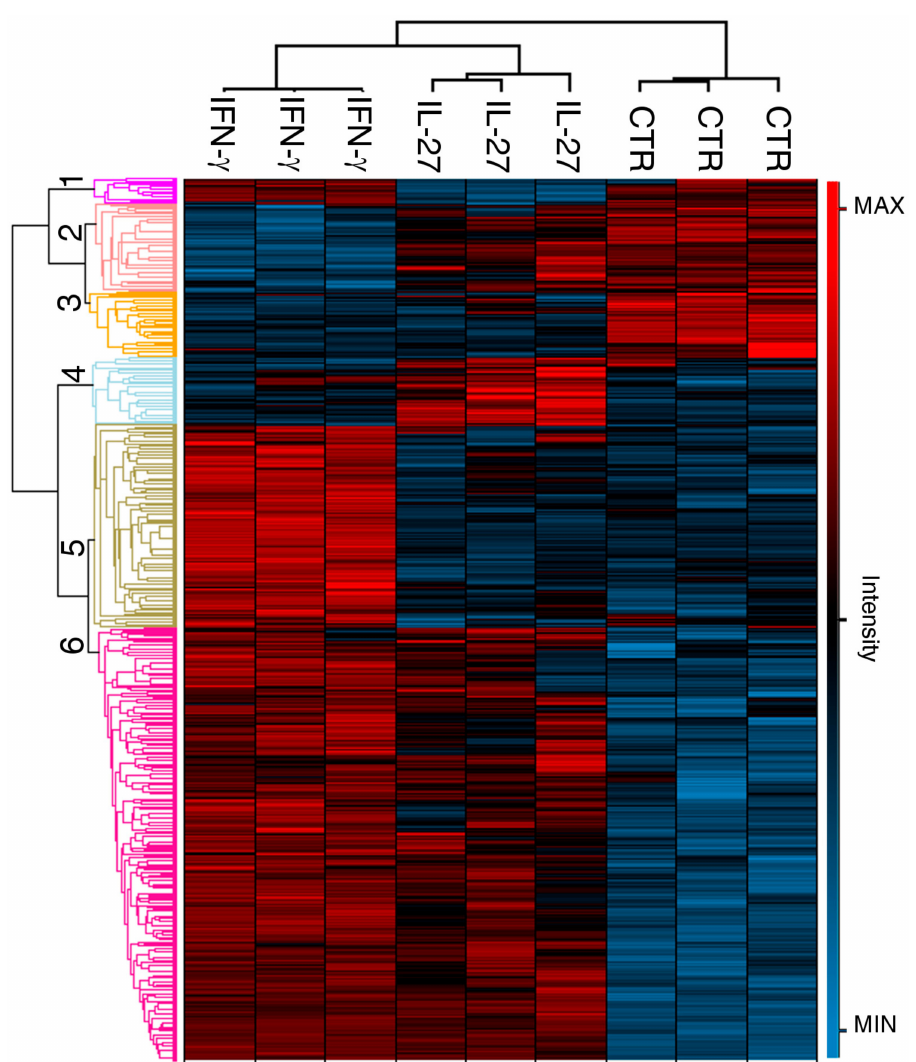
Figure 1. Heatmap of 699 cytokine-modulated proteins selected by multiple-samples test ANOVA, performed on the SKOV3